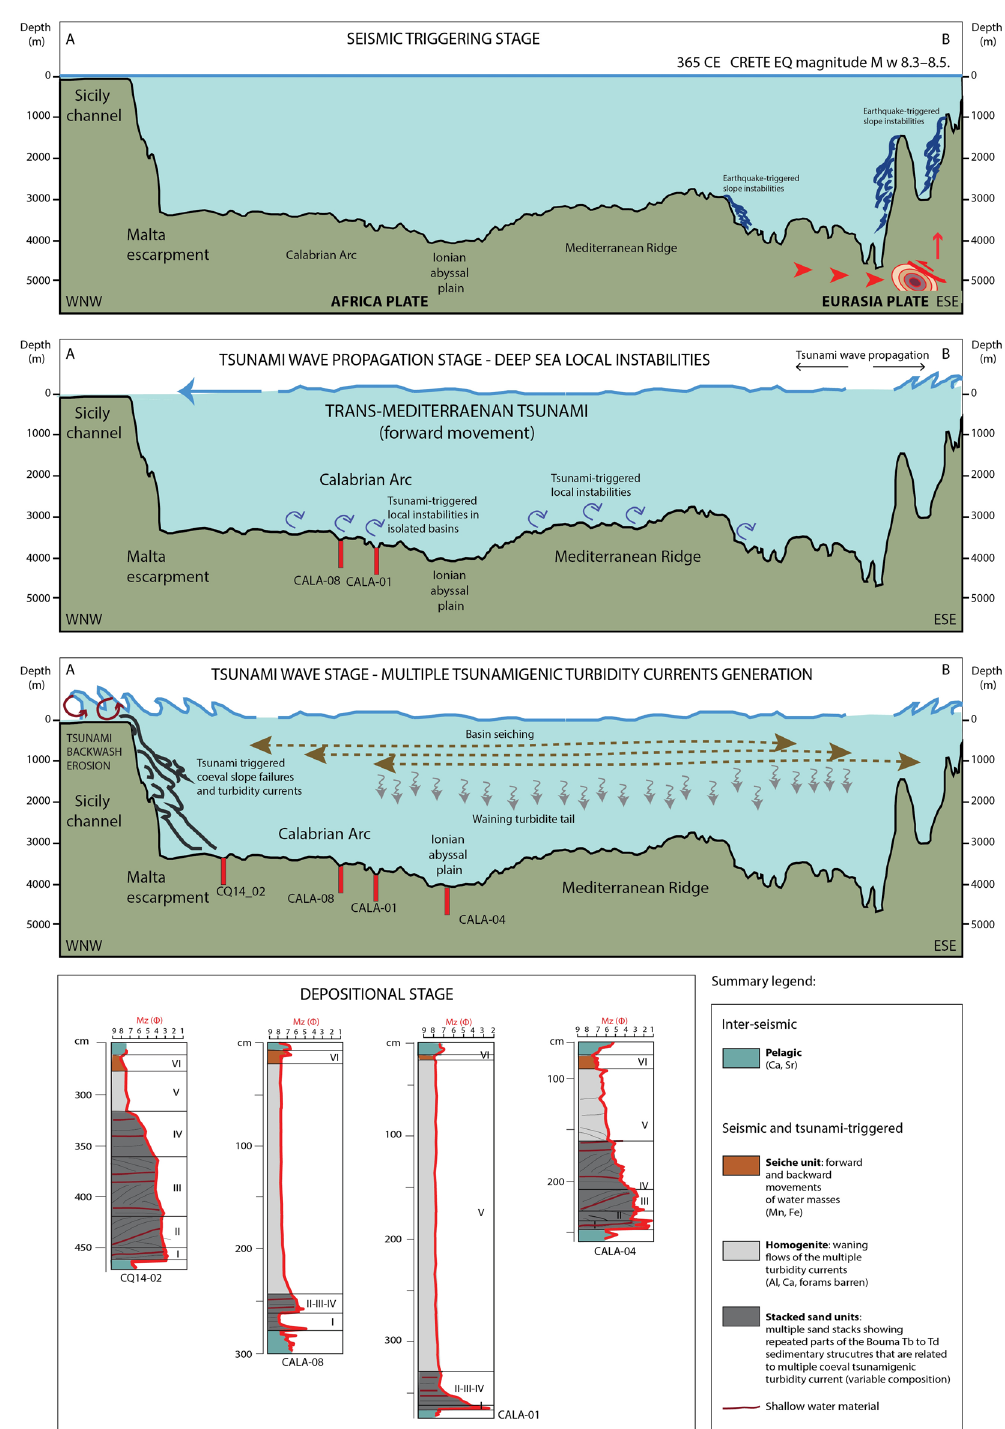
Figure 10. Bathymetric profile A-B across the Eastern Mediterranean Basin (see Fig. 1 for its location) and the conceptual model showing: ( a ) earthquake-generated processes; ( b ) propagation of a tsunami wave in the deep water generated by seafloor offset along a fault plane and by slope failures; ( c ) sedimentary processes related to multiple seismically triggered slope failures, resulting in multiple turbidity currents (black lines), waning turbidity currents (grey lines), seiching of confined basin water masses (brown dotted lines) and seafloor erosion of shoreline and shelf by tsunami wave backwash flows (red lines on the shelf); d) the resulting sedimentary processes deposits we observe in our cores in the different settings. Above the stacked sandy base (black), graded homogenite muds (grey), homogenite (grey) and laminites (brown). The figure was created using Adobe Illustrator (CS6; https:// www. adobe.